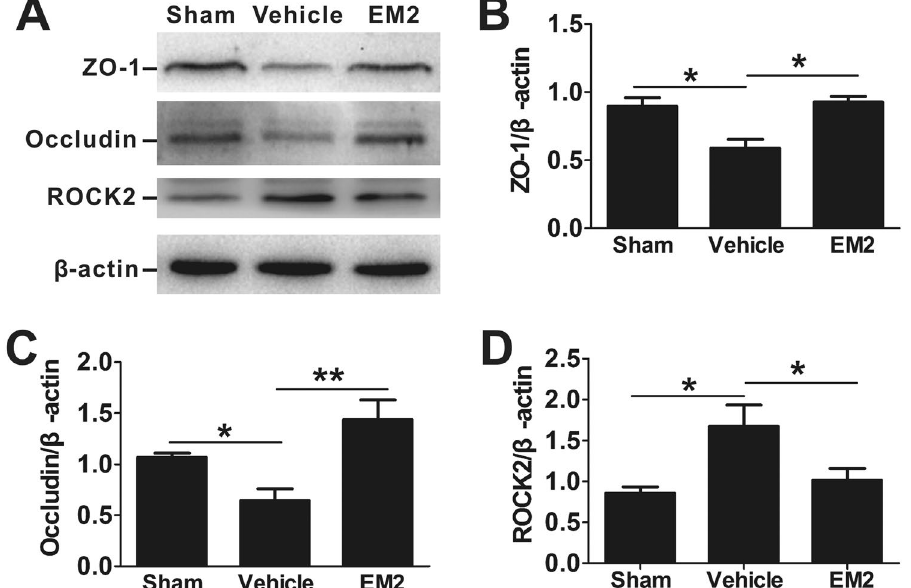
Figure 6. EM2 attenuates the disruption of tight junction proteins following focal cerebral I/R. ( A ) Western blot analysis for ZO-1, Occludin and ROCK2 in cerebral hemisphere after 24 h reperfusion. ( B , C and D ) Quantitation of ZO-1, Occludin and ROCK2 expression, respectively, normalized to β -actin. The data are presented as means ± S.E.M. (n = 4–5). * p < 0.05, ** p < 0.01 compared with indicated group.